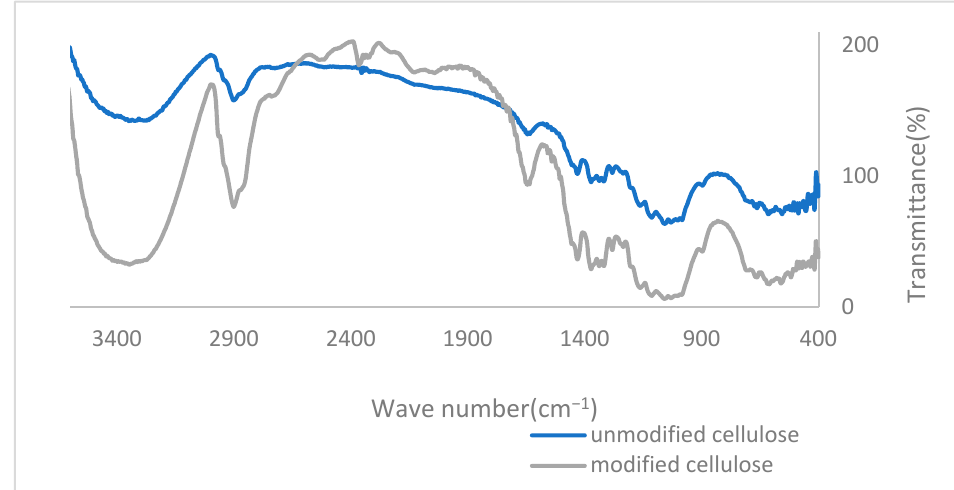
Figure 4. FT-IR spectra of cellulose and modified cellulose.